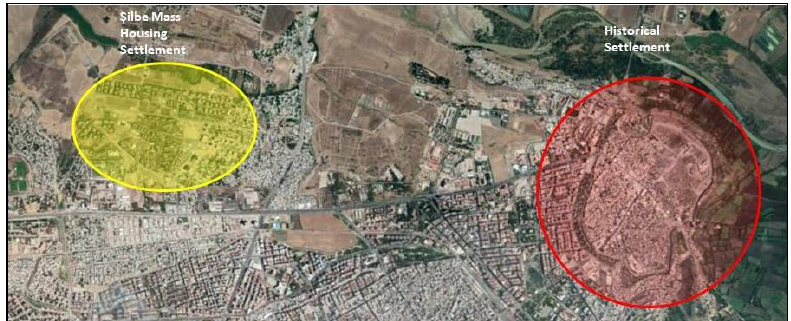
Figure 3. Satellite view of historical Old Town texture—Şilbe collective housing settlement unit [17,18].